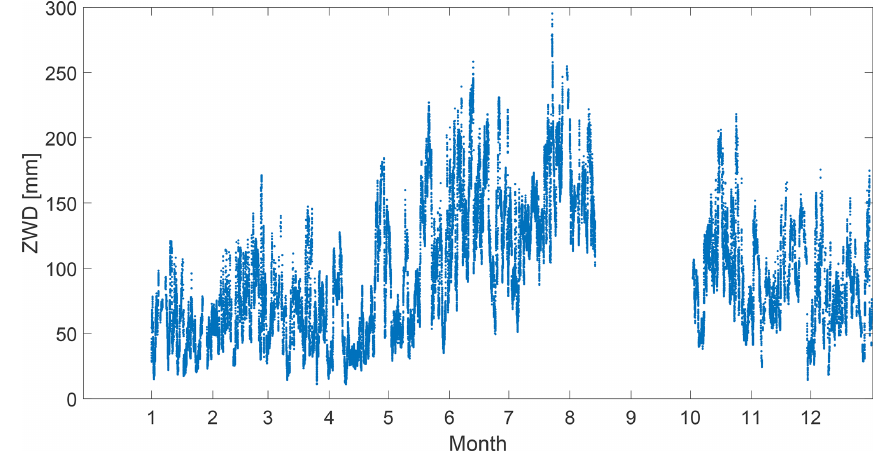
Figure 5. The time series of the ZWD estimated from the WVR data for each 5min cycle. The radiometer was repaired from mid-August to early